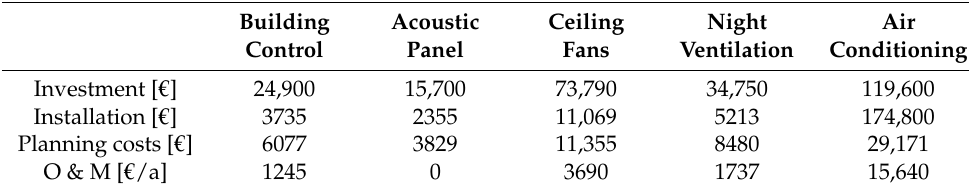
Table 8. Component costs